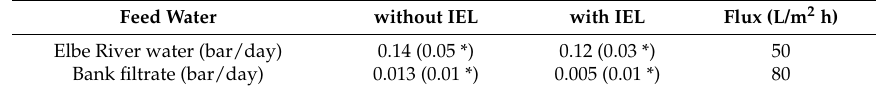
Table 4. The fouling potential with and without backwash water from inline electrolysis (IEL) (n =